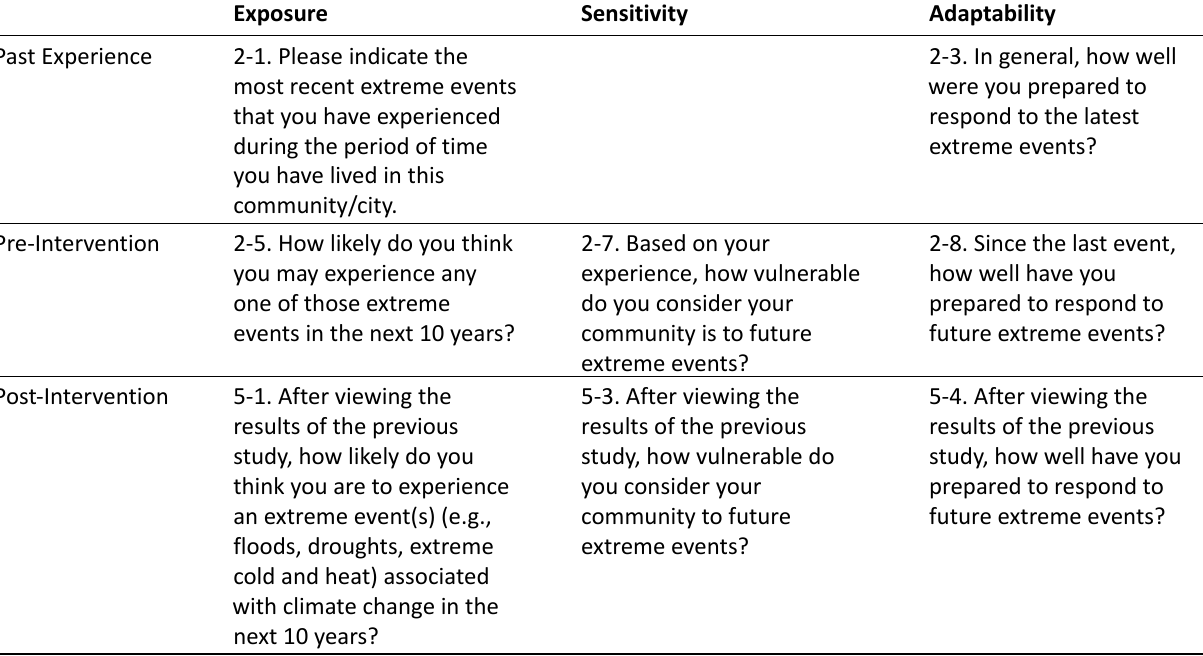
Table 3. Summary of measurement of risk perceptions aligned with dimensions of vulnerability—perceived exposure, sen- sitivity, and adaptability—across temporal scales of past experience, pre-intervention and